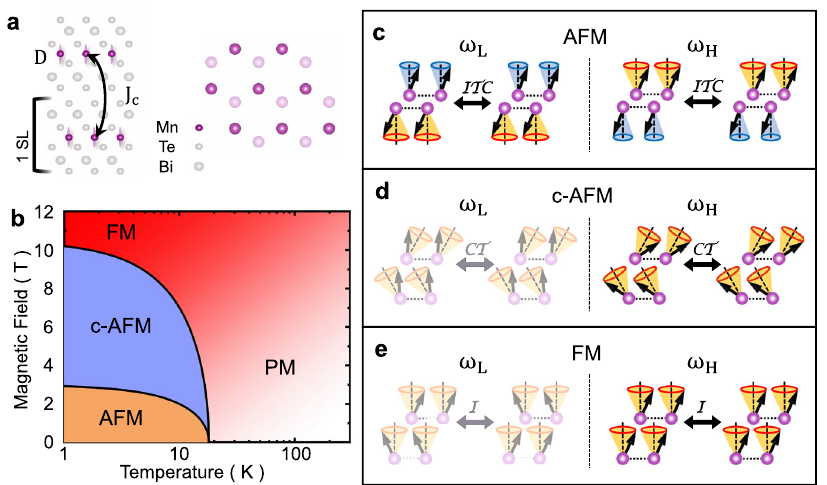
Fig. 1 Magnetic lattice, phase diagram, and magnon modes in a 2-SL MBT. a Illustration of two triangular magnetic lattices formed by Mn ions in the top (bottom) layer indicated by dark (light) purple spheres. The layers follow an ABC stacking order. D and J c represent anisotropy and interlayer exchange coupling. b Phase diagram as a function of temperature and an applied magnetic fi eld perpendicular to the 2D plane. c Magnons in antiferromagnetic (AFM) phase: spins from two layers oscillate with different amplitudes, corresponding to two magnon modes. Illustrations of spins before and after applying a time-reversal T , inversion I and two-fold rotational ( C w.r.t x -axis) operator ( ITC ). d Magnons in canted AFM (c-AFM) phase: the spin are canted at an angle with respect to the applied magnetic fi eld. Illustrations of spins before and after time-reversal and two-fold rotational ( y -axis) operator ( CT ). e Magnons in ferromagnetic (FM) phase: spins in the two layers oscillate in-phase or out of phase. Illustrations of spins before and after inversion operator ( I ). Shaded modes are either Raman silent or near zero frequency. ω L ( ω H ) refers to the magnon branch with a higher (lower) frequency in the left (right) column.